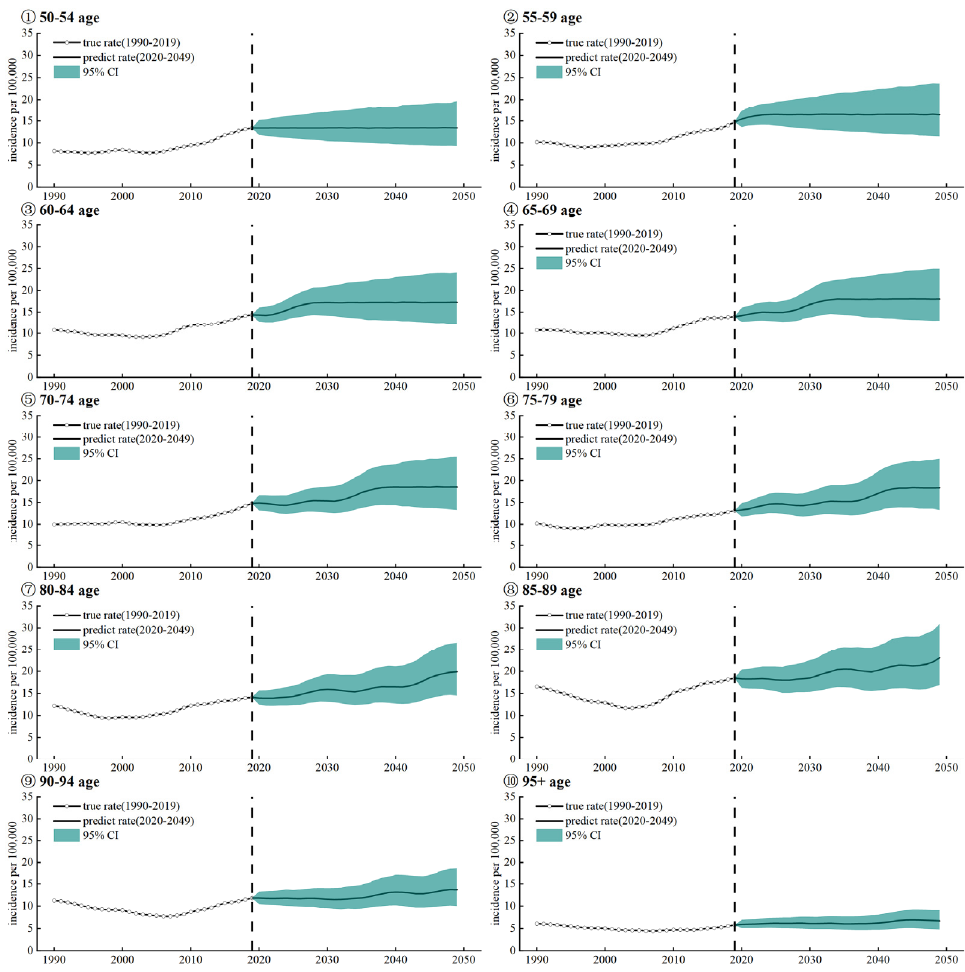
Figure 5. Prediction of nasopharyngeal carcinoma incidence among females and males in China from 2020 to 2049 based on the Bayesian APC model.